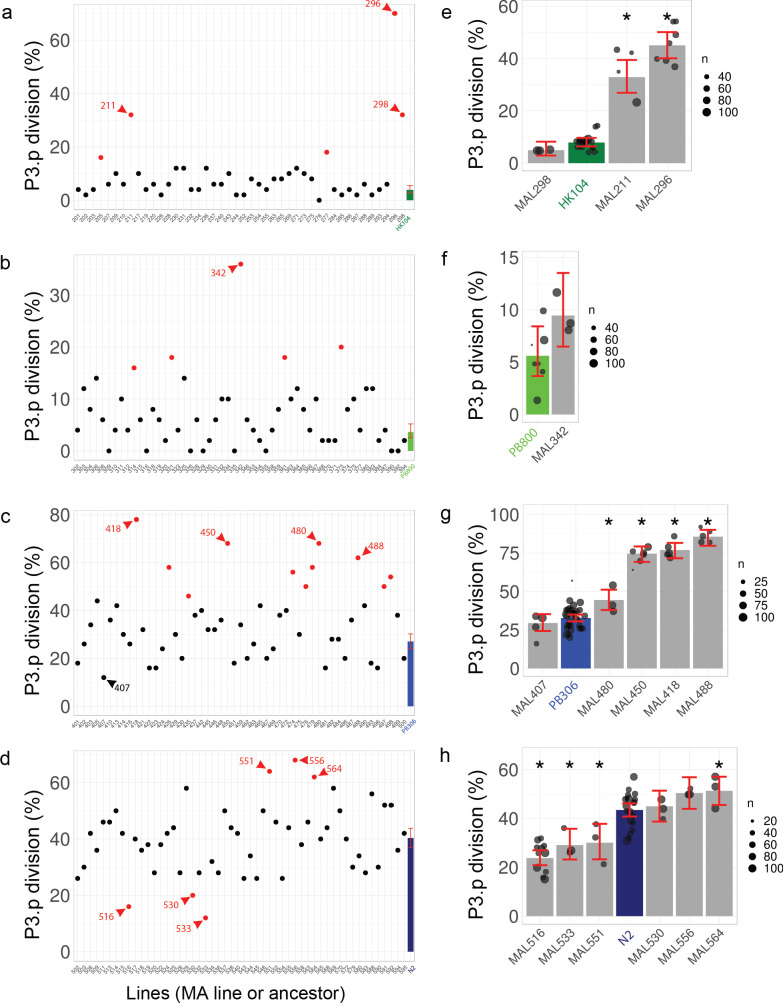
Selection of MA lines with evolution of P3.p cell fate compared to their ancestor line.(a–d) Data from Braendle et al., 2010. Each MA line was scored once (n = 50 individuals) while each ancestor was scored 17 times (n = 17×50=850). Scores for the ancestor are summarized with a colored bar on the right side of each plot. Red dots indicate lines with a P3.p division frequency significantly different from the ancestor (Fisher's exact test corrected for mutliple tests, fdr level: 0.05). MA lines that were scored again in the present study (E–H) are indicated by an arrowhead. (e–h) Scoring of P3.p division frequency for a subset of MA lines. The bar charts represent the mean frequency of P3.p division over several independent experiments featured as dots whose size scales to the number of animals scored. Data for ancestors and selected MA lines are also reported in Figure 2B. Stars indicate significant differences of mean P3.p division frequency between a MA line and its ancestor (Fisher's exact test, fdr level: 0.05). Error bars are 95% confidence intervals.